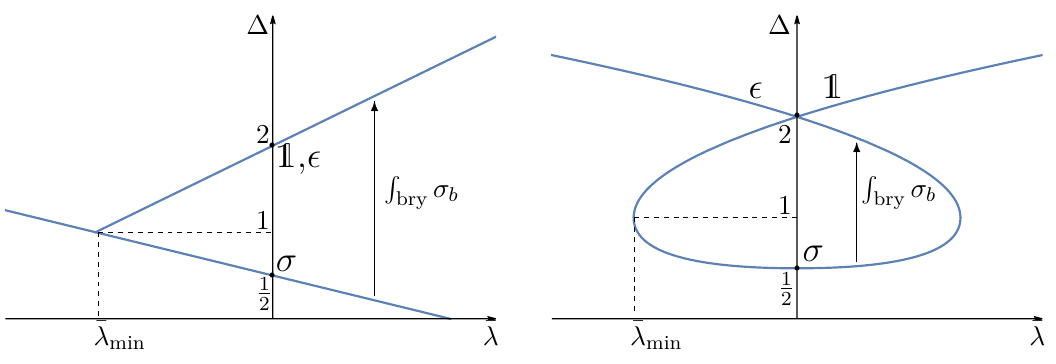
Figure 34. Sketch of the scaling dimension of the first boundary operator (above the identity) for the Ising field theory in AdS . The black dots mark the three possible BCFTs (labeled by 2 1 , (cid:15) and σ ) for the Ising minimal model. On the left, we show the thermal deformation that is exactly solvable in terms of a massive free fermion [18]. On the right, we show (our best guess for) the magnetic deformation. The curve marked 1 was studied with Hamiltonian truncation (see figure 32). The curve marked (cid:15) is obtained from this one by the Z (spin flip) symmetry of the Ising 2 model. This Z symmetry implies that the right picture should be symmetric under the reflection 2 ¯ ¯ ¯ ¯ λ → − λ . We conjecture that the curves merge (smoothly) at λ = ± λ min ≈ ± 0 . 1 and ∆ = 1 . There is also a boundary RG flow generated by the relevant boundary operator with ∆ < 1 that goes from the lower to the upper curves. In the right plot, the flow is expected to land on the first stable fixed point. This is clearly visible from the perturbative beta function (6.1) close to ¯ λ , which min describes a one-parameter